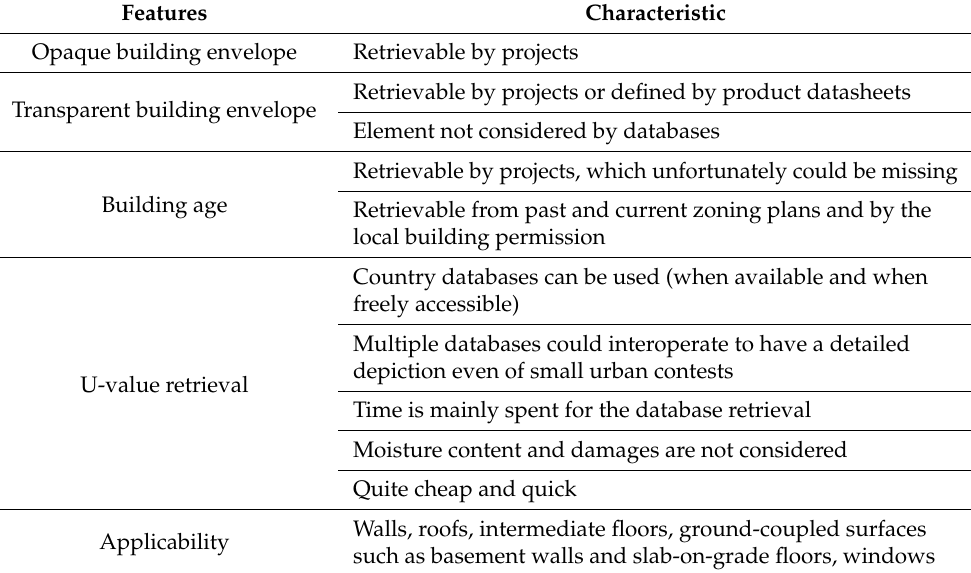
Table 3. Characteristics of analogy with coeval building (source: authors’